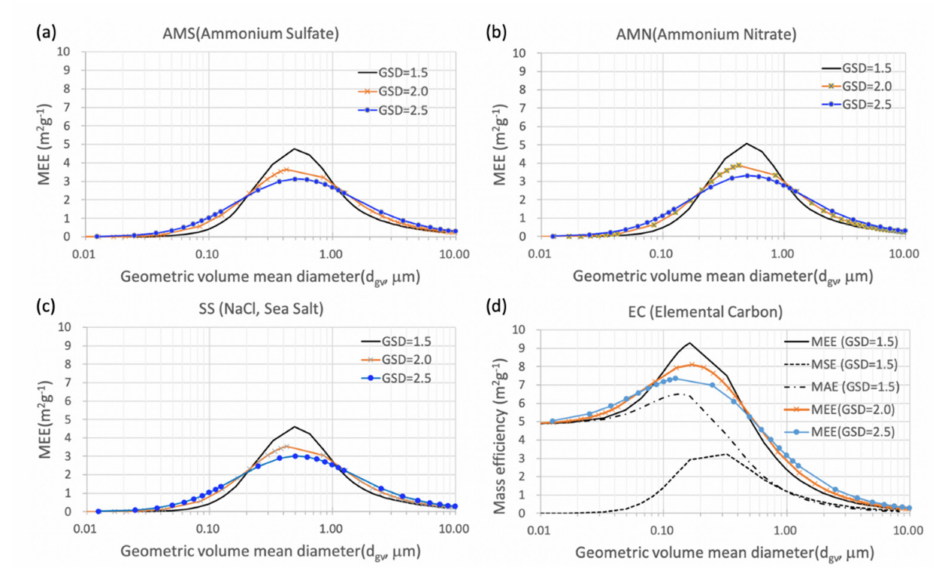
Figure 2. The calculated mass extinction e ffi ciency (MEE) of ( a ) ammonium sulfate (AMS), ( b ) ammonium nitrate (AMN), ( c ) sea salt (SS, NaCl), and ( d ) elemental carbon (EC) as a function of geometric volume–mean diameter with varying geometric standard deviations (GSD) of 1.5, 2.0, and 2.5. For EC with GSD = 1.5, mass scattering e ffi ciency (MSE) and mass absorption e ffi ciency (MAE) are also embedded. Table 2. The mass extinction e ffi ciency (MEE, m 2 g − 1 ) determined in the original Malm’s equation [8] and Pitchford’s revised method [6]. Pitchford Revised Method MEE Original Malm Aitken Accumulation Coarse Equation Mode Mode Mode Ammonium sulfate and ammonium nitrate Organic carbon Sea salt Coarse mass Elemental